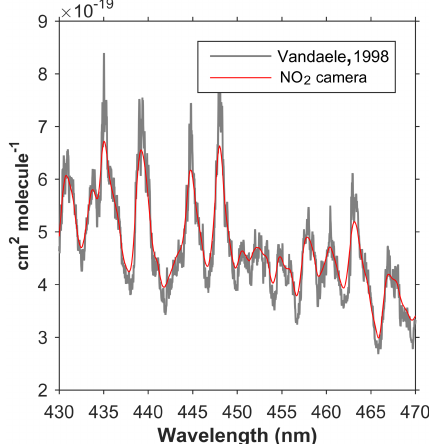
Figure 3. NO 2 absorption cross section measured with a Fourier transform spectrometer (gray line; Vandaele et al., 1998) and with this NO 2 camera in the laboratory (red line). At 450nm, the spectral resolution of both datasets are 0.04 and 0.6nm